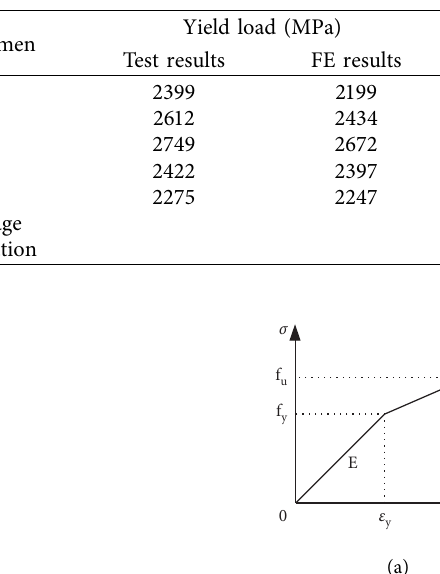
Table 3: Feature parameters of key points.